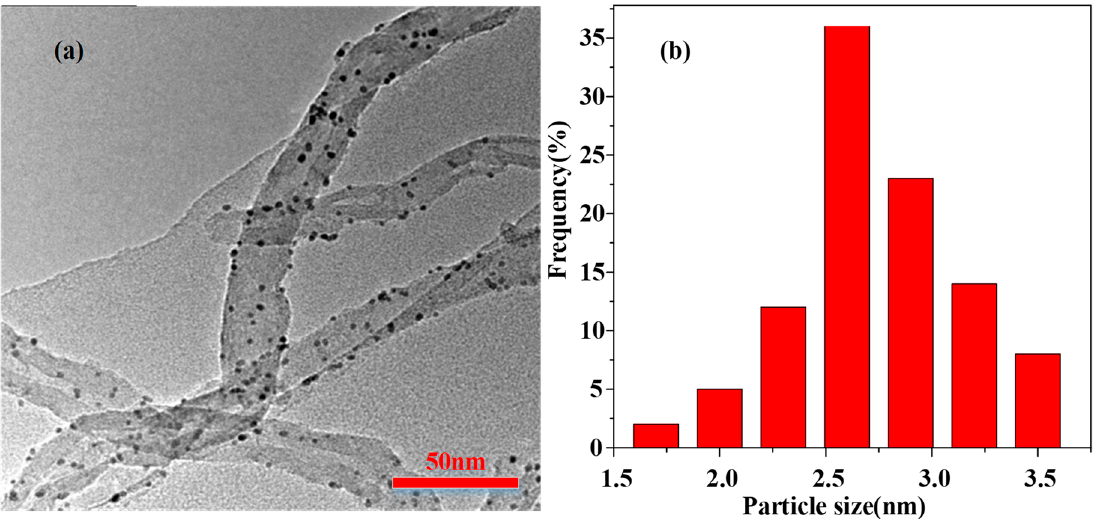
Figure 3. TEM images of ( a ) 3.0 wt% Pd Pd/CNTs and ( b ) particle distribution.